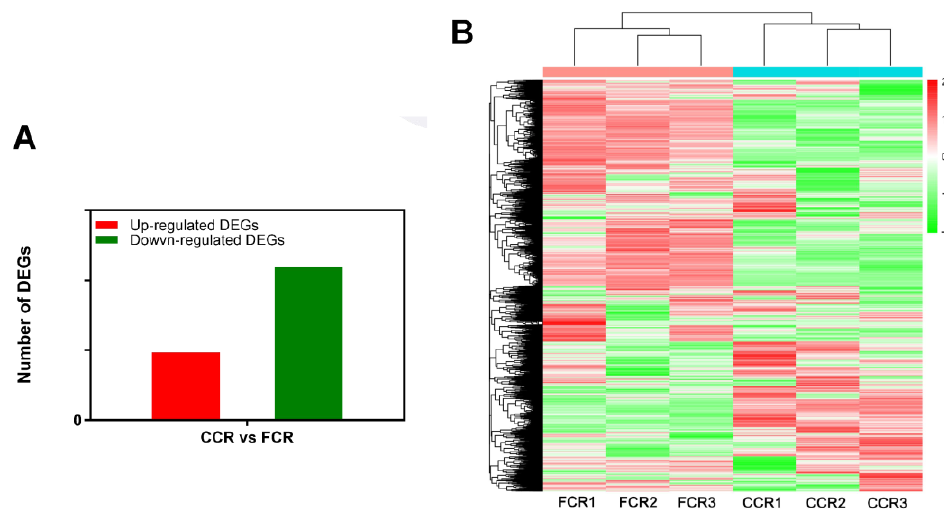
Figure 3. Analysis of differential gene expression in CC vs FC root tissues of P. odoratum . ( A ) Up- regulated and down-regulated the amount of DEGs. FCC stands for the root samples of the first cropping, and CCR stands for root samples of consecutive cropping. ( B ) Heatmap and clustering analysis of DEGs. FCC stands for the root samples of the first cropping, and CCR stands for root samples of consecutive cropping.